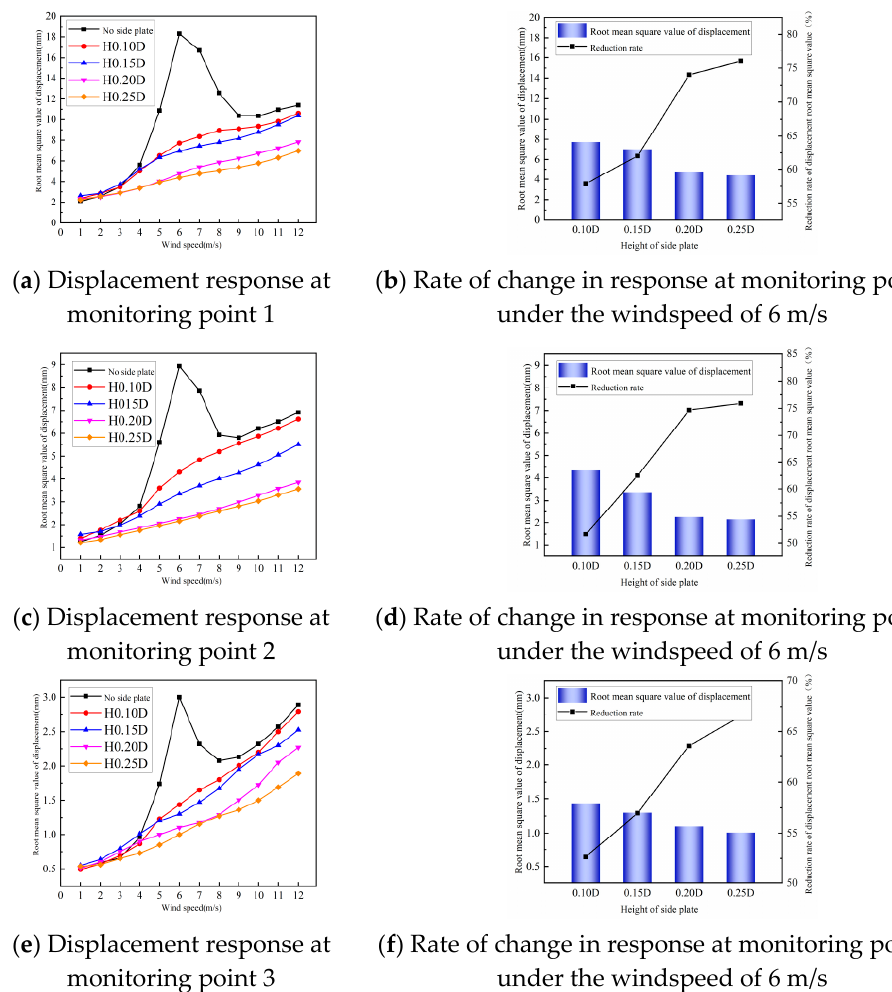
Figure 26. Root mean square value of the crosswind displacement response at the monitoring points of the high light pole structure under different side plate height conditions.